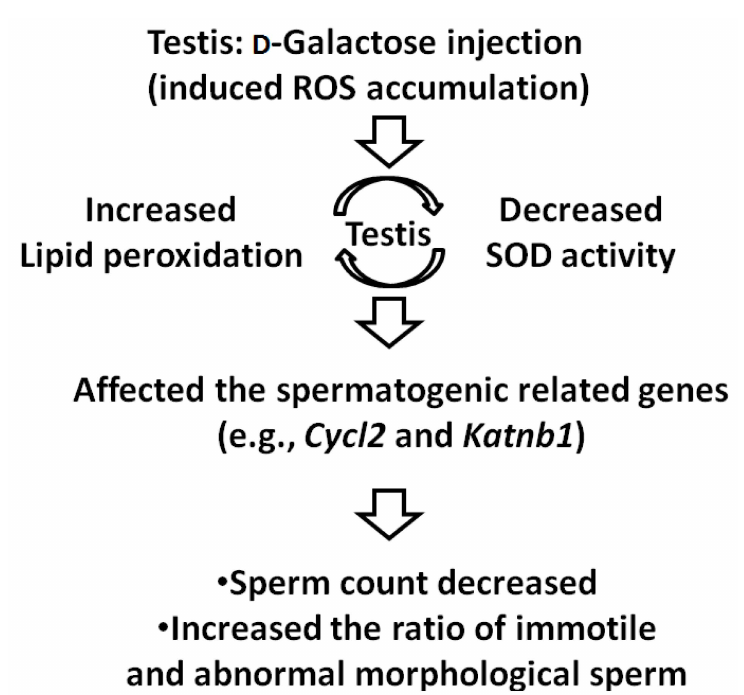
Figure 5. Mouse model of male reproductive aging induced by D -Galactose injection. The D -Gal-injected mice demonstrated decreased SOD activity and increased lipid peroxidation amount. Further, SOD accumulation affects the expression of spermatogenic genes (e.g., Cycl2 and Katnb1 ) and results in the decreased sperm count and increased ratio of immotile and abnormal sperm